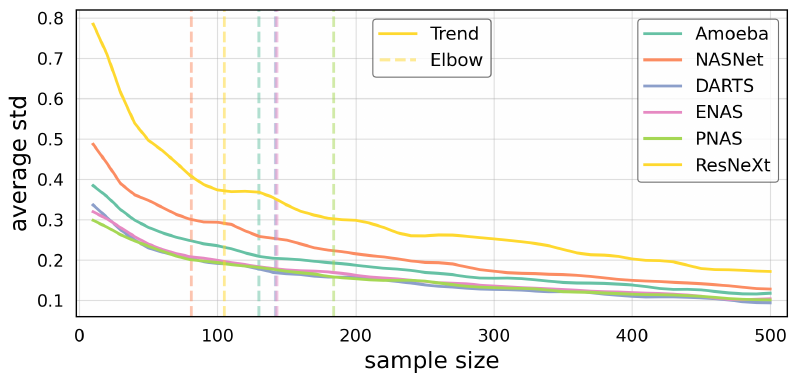
Figure 2. Trendlines of the average standard deviation on the accuracy/FLOPs curve for increasing sample size, together with their elbow points where the extra cost to train extra networks is not worth